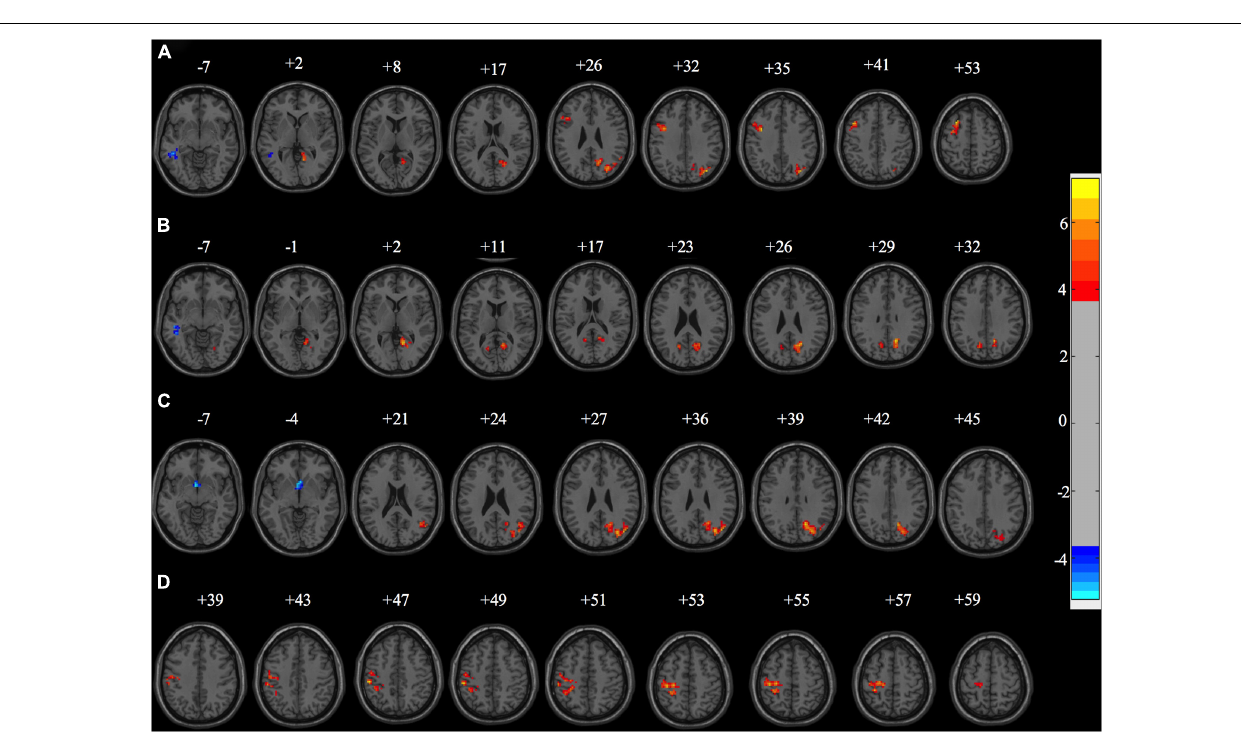
FIGURE 3 | Fraction amplitude of low-frequency fluctuation differences between the sub-groups of PD patients and healthy controls (HC). (A) fALFF differences between PD + VDD and HC (corrected for multiple comparisons, at GRF, p < 0.01). (B) fALFF differences between PD + VDI and HC (corrected for multiple comparisons, at GRF, p < 0.01). (C) fALFF differences between PD + NVD and HC (corrected for multiple comparisons, at GRF, p < 0.01). (D) fALFF differences between PD + VDD and PD + NVD (corrected for multiple comparisons, at AlphaSim, p < 0.05). Red: increased fALFF. Blue: decreased